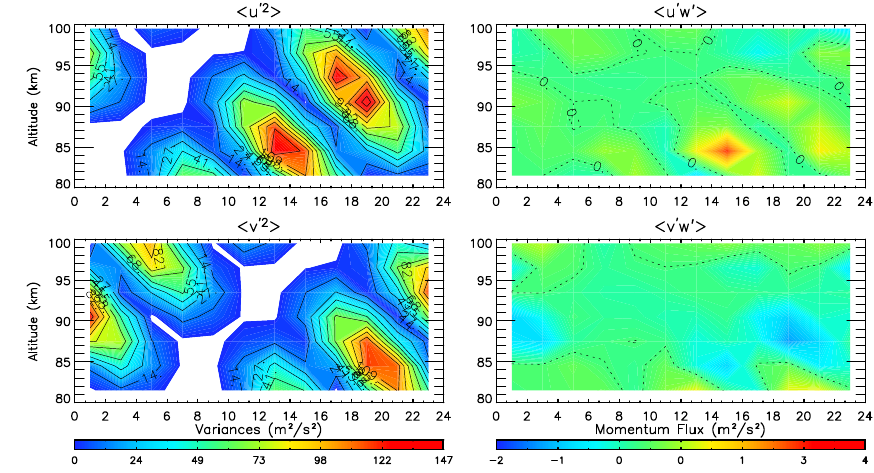
Fig. 9. Variances and momentum fluxes from Hocking’s analysis using simulation without GWs.